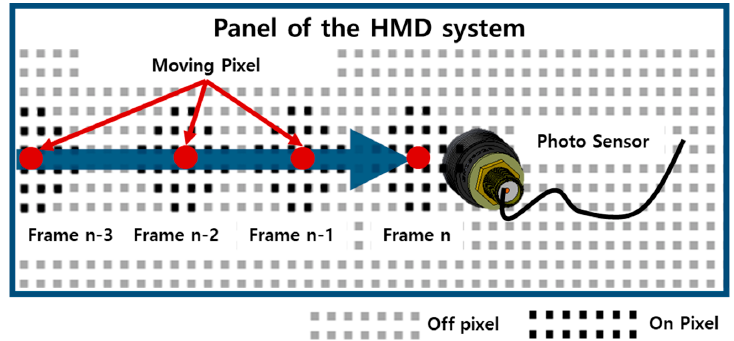
Figure 10. Examples of image changes according to the physical movement of the HMD system: ( a ) an initial image, ( b ) an image generated when a user moves down, ( c ) an image generated when a user moves right, and ( d ) an image generated when a user moves left.